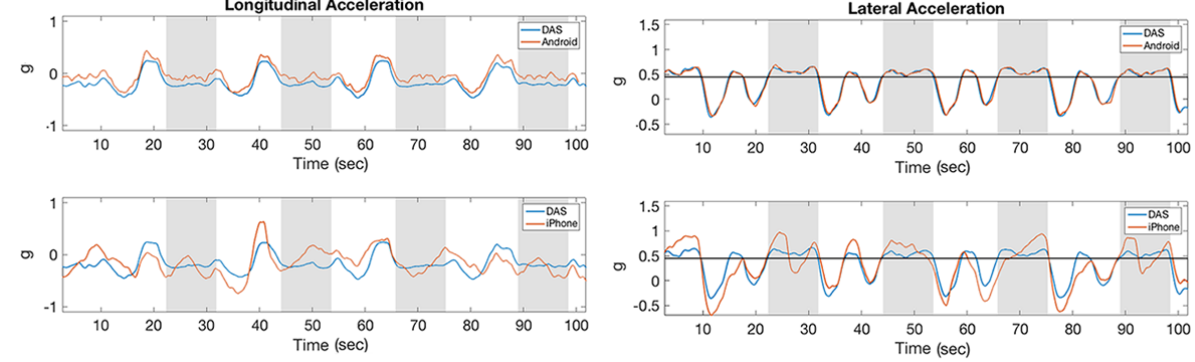
Figure 8. Acceleration measurements for hard left cornering maneuvers. The horizontal line along lateral acceleration represents the threshold of 0.45 g. Shaded stripes identify the approximate time of the cornering maneuvers. DAS: data acquisition system.